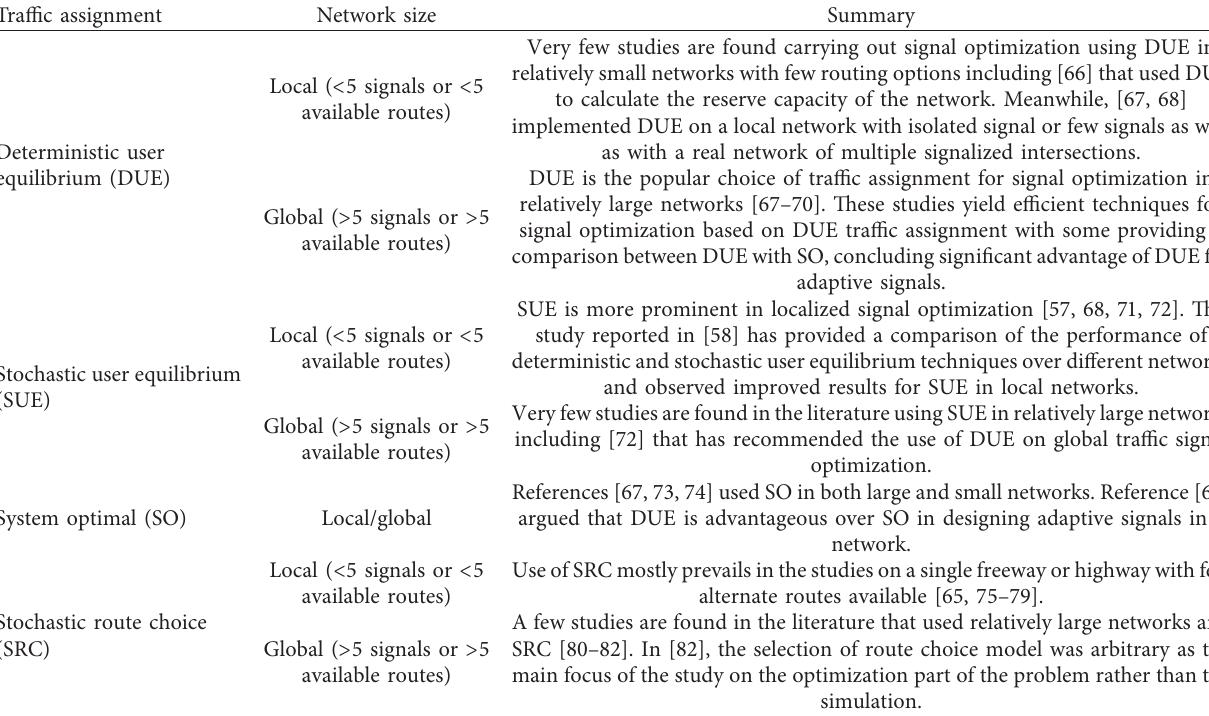
Table 1: A summary of literature on simulation-based traffic signal optimization studies.